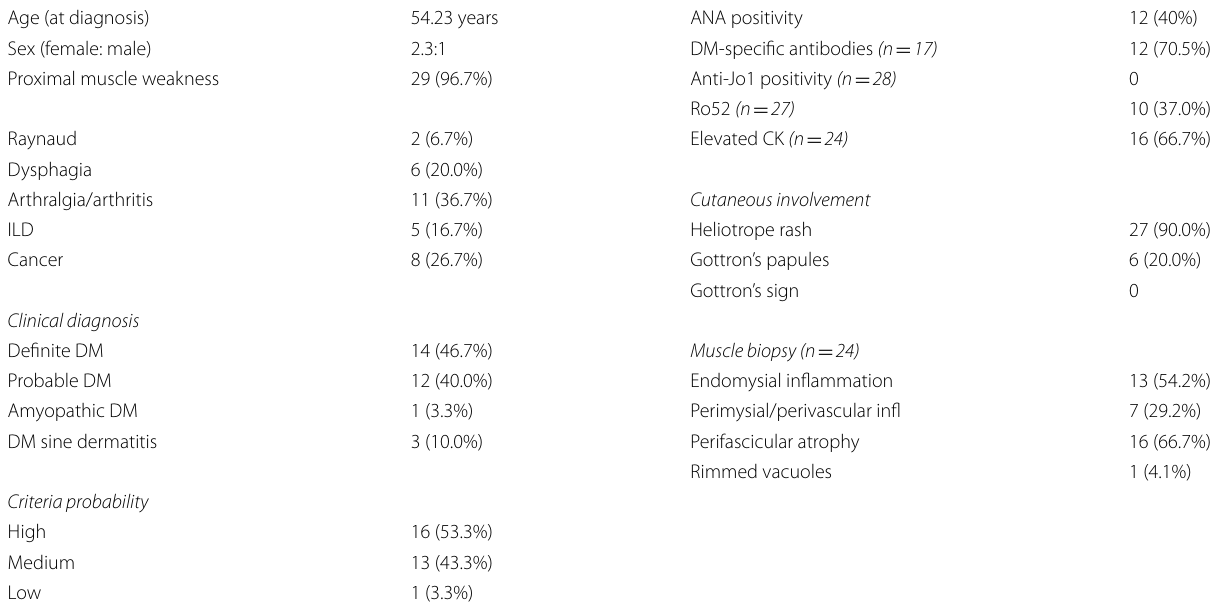
ILD interstitial lung disease, DM dermatomyositis, ANA antinuclear antibody, CK creatine kinase